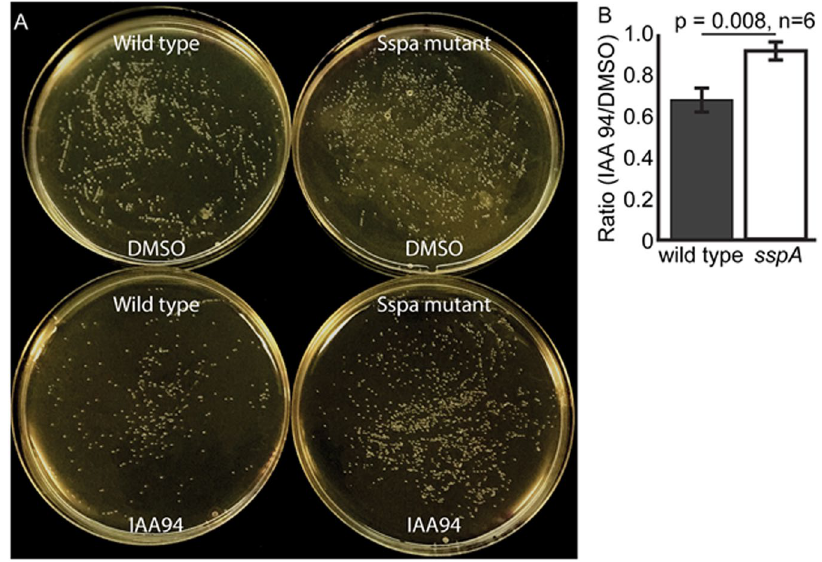
Figure 6. Effect of IAA-94 on E. coli . ( A ) E. coli growth on the LB agar medium with and without IAA-94. DMSO was used as a solvent control. Wild-type E. coli showed less number of colonies in the presence of IAA- 94 but SspA mutant had no effect of IAA-94. ( B ) The ratio of a number of colonies present in IAA-94 vs DMSO for wild type and SspA mutant. IAA-94 significantly reduced the number of colonies (p ≤ 0.01, n = 6) for the wild type as compared to the SspA